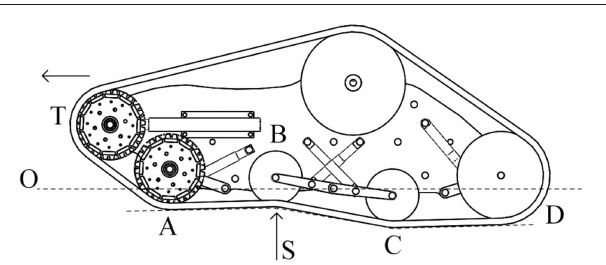
FIGURE 4 | Example of suspension configuration.